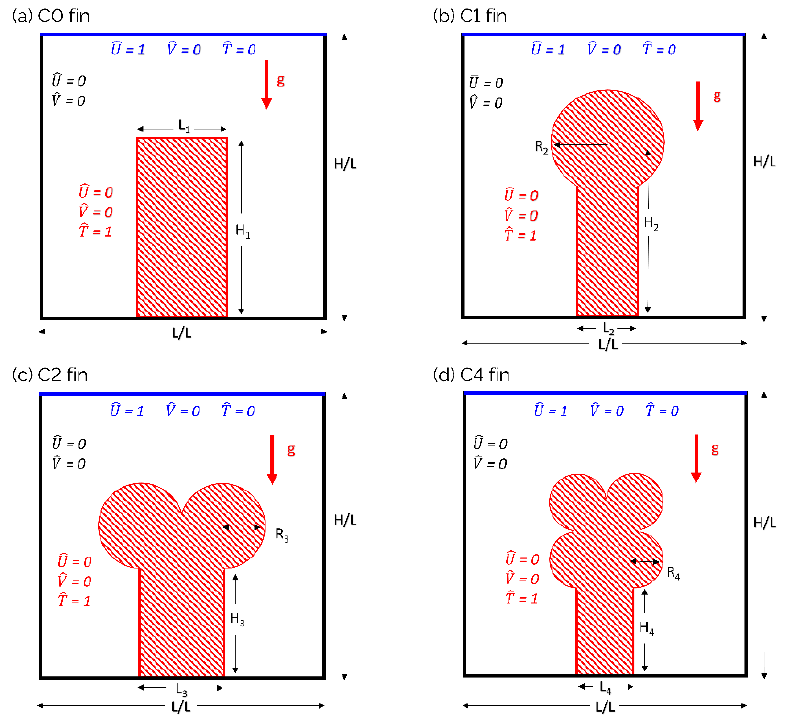
Figure 2. Diagram of the lid-driven cavity intruded by a constant temperature fin. ( a ) rectangular fin (C0), ( b ) fin with one facsimile alveolus (C1), ( c ) fin with two facsimile alveoli (C2), ( d ) fin with four facsimile alveoli (C4). Here, the fin area is fixed ( A fin = 0.2) with respect to the cavity area in all cases.